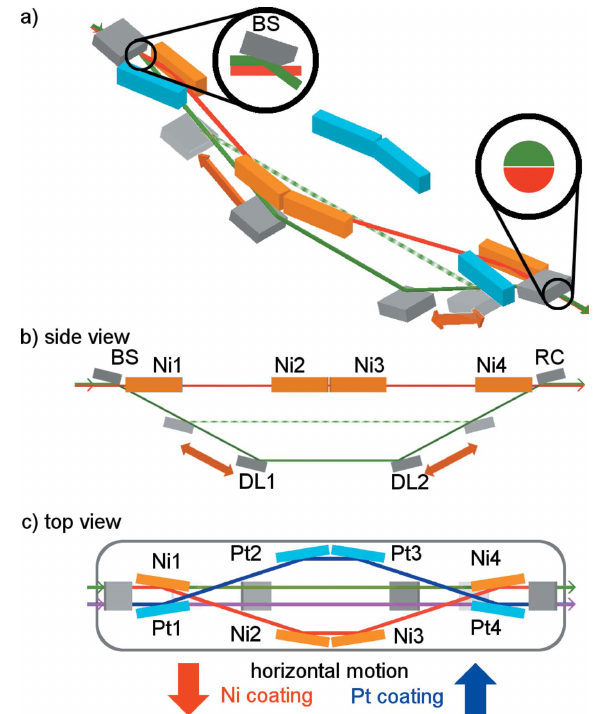
Figure 1 Schematic drawing of the SDU showing FEL beams utilizing the Ni- coated mirrors (orange). The initially top section of the beam (green) is reflected by the beam splitter mirror (BS) downwards into the variable delay path (gray mirrors). The mirrors DL1 and DL2 can be moved along the beam path as indicated by the orange arrows and induce a temporal delay into this beam. The initially lower section of the FEL beam (red) passes the BS unreflected (see top inset) and propagates in the fixed delay path (Ni1–Ni4, orange mirrors). Both beams are recombined at the recombining mirror (RC, see lower inset). A small gap between both beam parts remains after leaving the SDU. The optical bench [gray frame, in ( c )] can be moved horizontally to change the positioning from the Ni- to the Pt-coated mirrors Pt1–Pt4 (light blue). In the variable delay path the Ni and Pt coatings are evaporated side-by-side on the mirrors BS, DL1, DL2 and